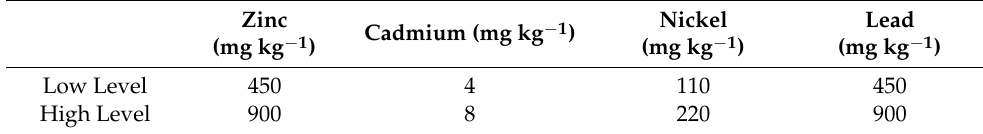
Table 1. Amounts of contaminants supplied to the soil in the different studied